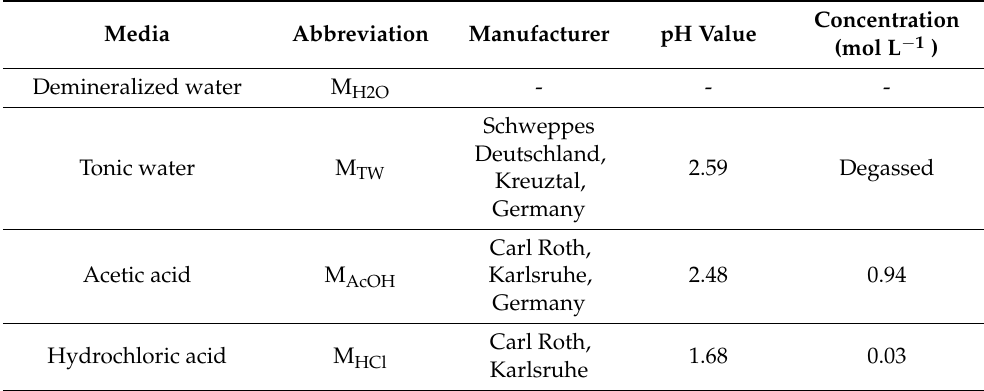
Table 2. Liquids to which the test specimens were